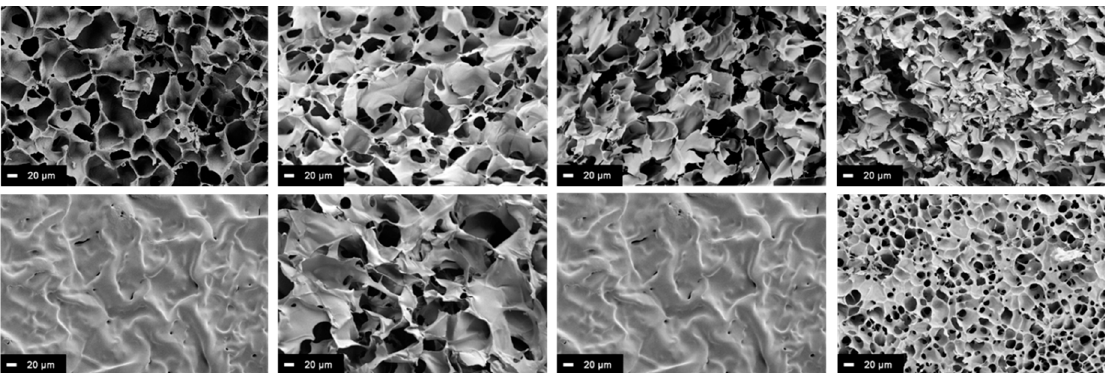
Figure 7. SEM images of different prepared cryogels. The upper row shows the fracture surfaces, the lower row the surfaces. From left to right: PEGDA = polyethylene glycol diacrylate cryogel; HA-A = hyaluronic acid acrylate cryogel; Dex-MA = dextran methacrylate cryogel; CS-MA = chondroitin sulfate methacrylate